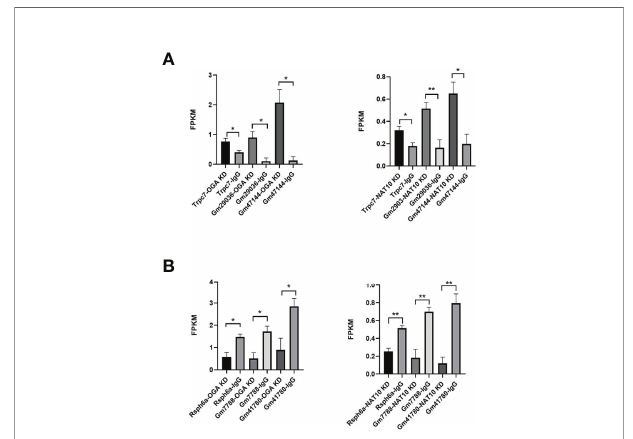
FIGURE 7 | Co-regulated genes of NAT10 and OGA in oocyte maturation. (A) Common upregulated DEGs and their expression in NAT10 KD and OGA KD transcriptomes. (B) Common downregulated DEGs and expression in NAT10 KD and OGA KD transcriptomes. * P < 0.05 and ** P <